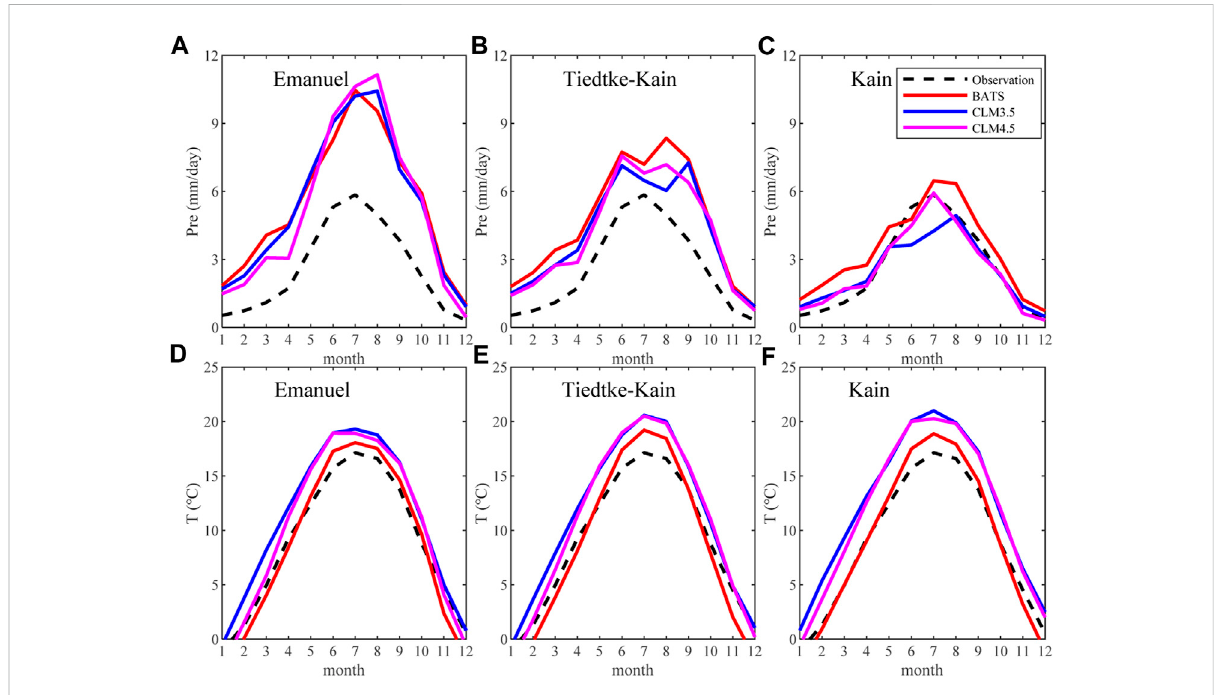
FIGURE 7 Observedandsimulatedannualcyclesofprecipitation(mm/day)andtemperature( ° C)fortheUYRB.[ (A) precipitationsimulatedbyEmanuel, (B) precipitation simulated by Tiedtke-Kain, (C) precipitation simulated by Kain-Fritsch, and (D – F) same as (A – C) but for temperature].